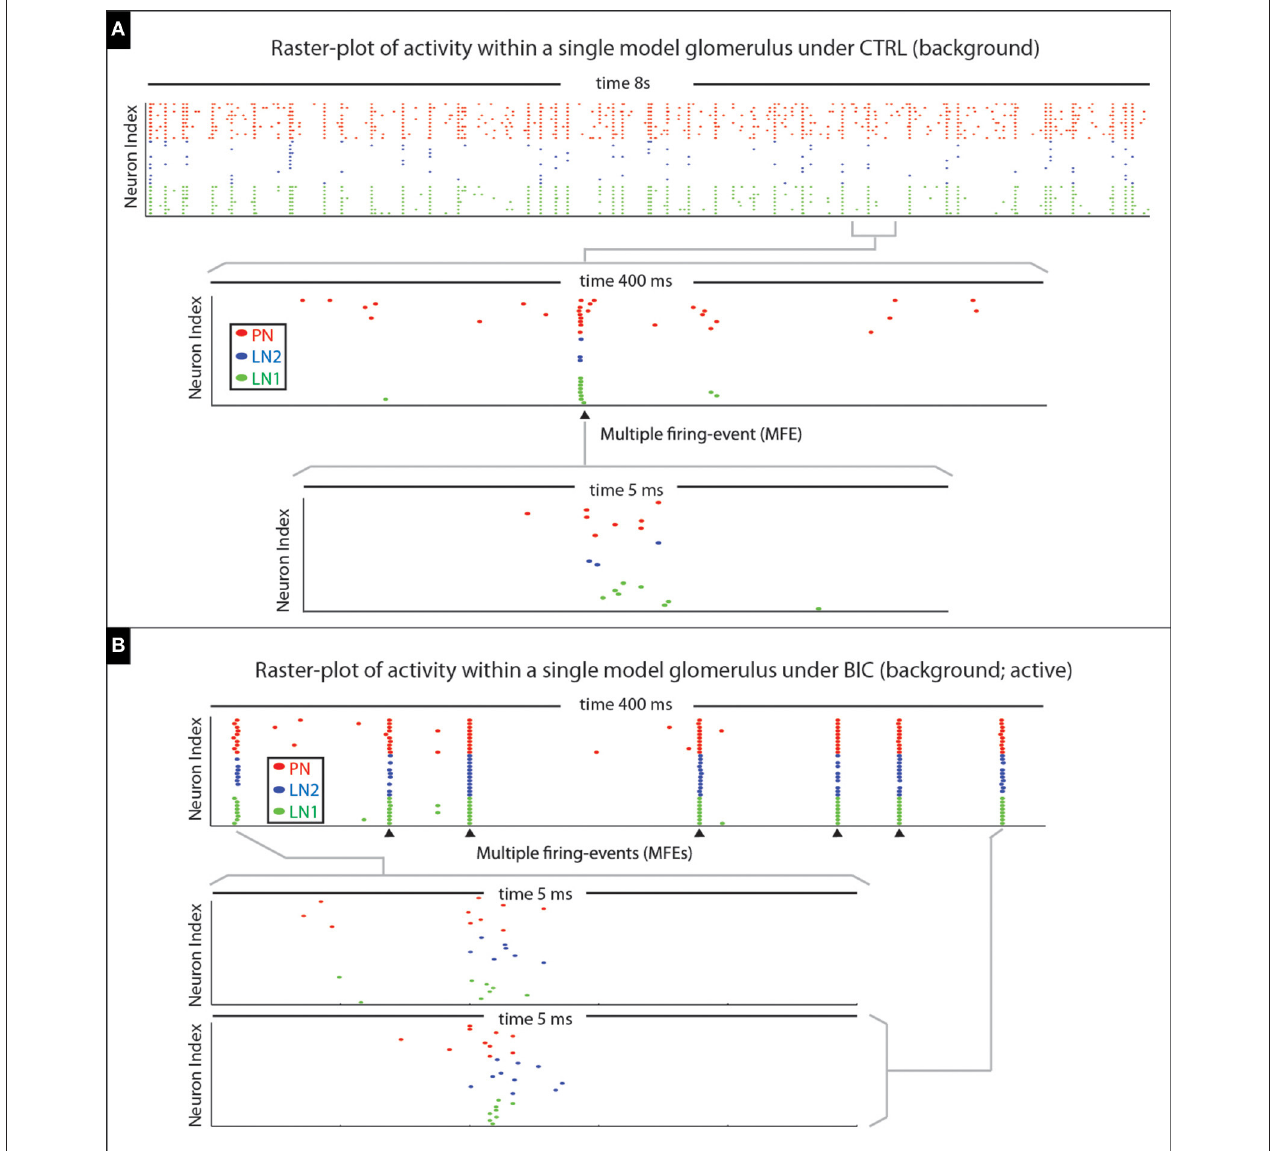
FIGURE 15 | Illustration of multiple-firing-events (MFEs) within our model network. (A) Here we show a raster-plot of spontaneous activity within a single model glomerulus from our network. The spikes associated with the different kinds of neurons are indicated via different colored dots. By zooming-in we can see an example of a MFE transpiring over ∼ 5ms. (B) Here we show a raster-plot of spontaneous activity spontaneous activity from the same model-glomerulus under the BIC-on condition, with two MFEs displayed in more detail underneath. This raster-plot is taken during an active-epoch, where this glomerulus is firing at roughly 20Hz. Two MFEs are shown in detail; the rest indicated with arrowheads. Note that the firing-events within each MFE are far from independent, instead occurring in brief synchronous bursts. In each case the MFE is precipitated by the firing of one or more PNs; these first few spikes trigger a cascade which includes more PNs, as well as LN1s and